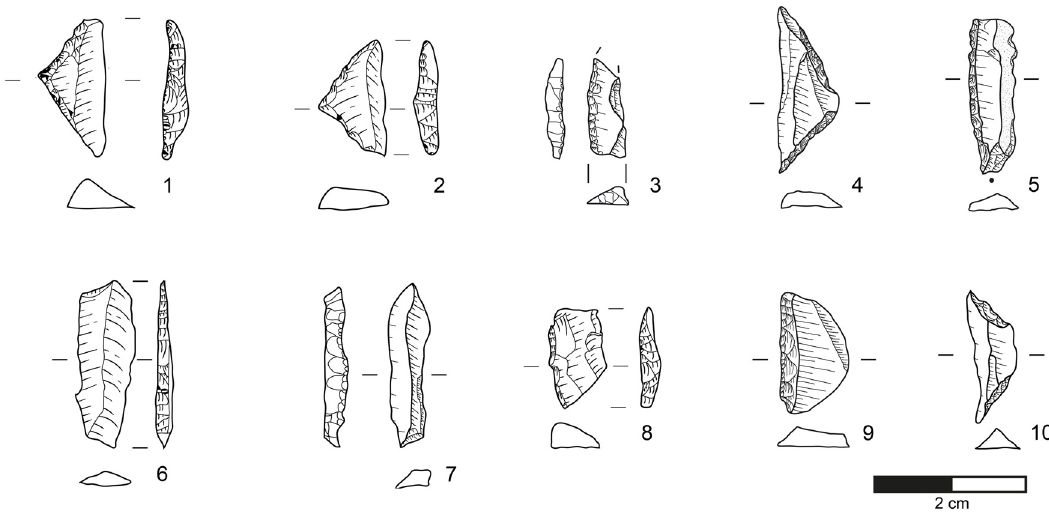
Figure 5: Microliths Egg - Schwarzwasser ( selection ) : 1 – 3 triangles, 4 trapeze, 5 – 8 backed bladelets, 9 crescent shaped microlith, 10 elongated trapeze. Drawings: J. Haas ( 1 – 2; 6, 8 ) ; C. Posch ( 3 – 5, 7, 9 – 10 ) .